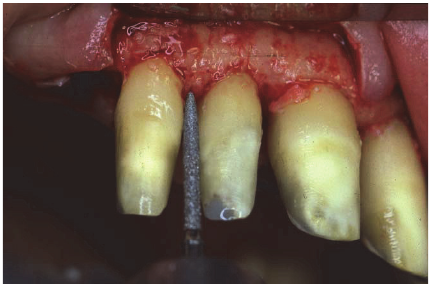
Figure 11: A feather-edge preparation was used for the abutment teeth, deeply modifying the root anatomy and opening the inter- proximal